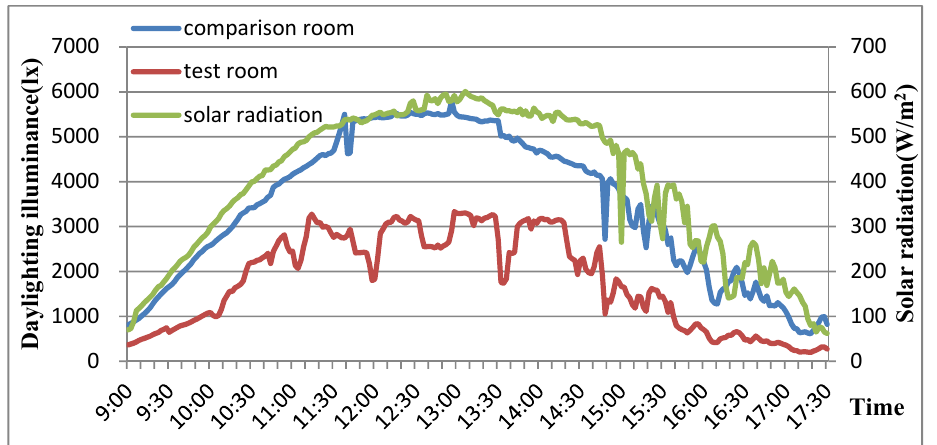
Figure 13. Illumination on work surface in 14 February 2018.